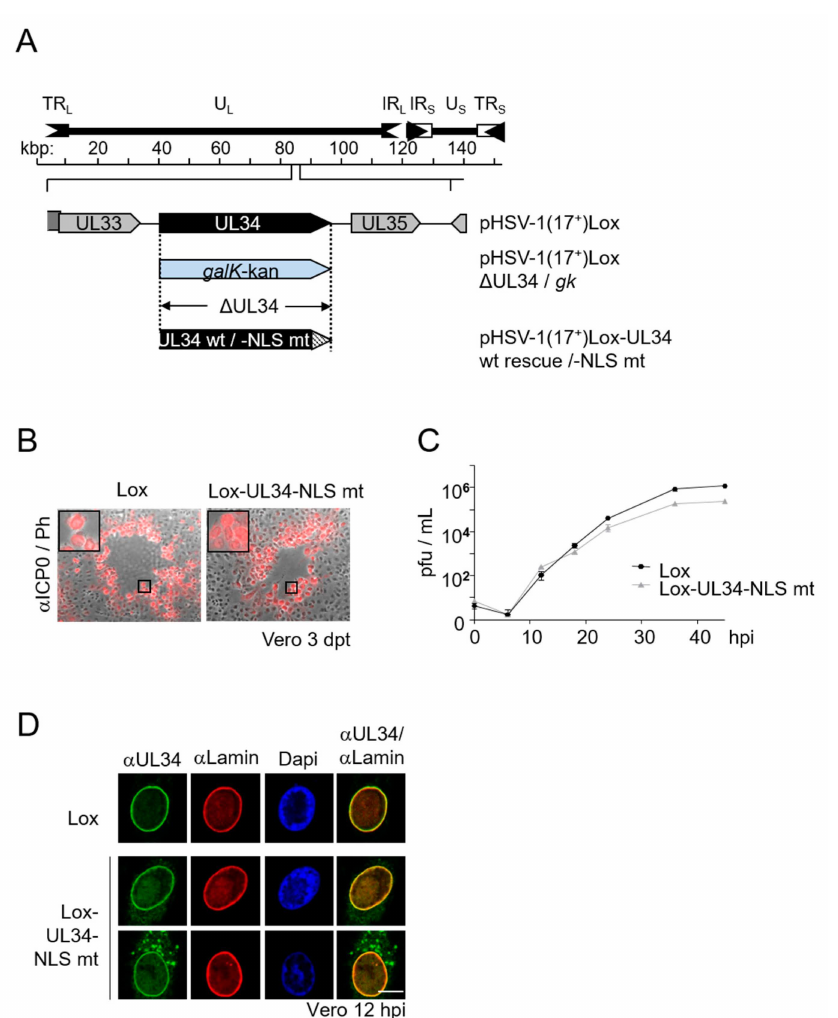
Figure 5. pHSV1(17 + )Lox-UL34-NLS mt is modestly compromised in viral replication. ( A ) Schematic depiction of the pHSV1(17 + )Lox genome, the localization of UL34 within the genome and the strategy for BAC mutagenesis. During BAC mutagenesis, UL34 is replaced by the galK -kan selection cassette (pHSV1(17 + )Lox- ∆ UL34/ gK ), followed by replacement of this cassette by the wild-type gene UL34 to reach pHSV1(17 + )Lox-UL34 wt rescue, or by UL34 harboring the NLS mutation to generate pHSV1(17 + )Lox-UL34-NLS mt. ( B ) To analyze virus propagation and plaque formation, Vero cells were transfected with BAC-DNA pHSV1(17 + )Lox and pHSV1(17 + )Lox-UL34-NLS mt, fixed 3 dpt